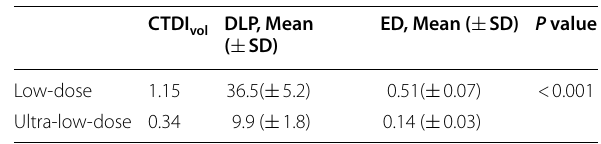
Table 5 Radiation dose results in low‑dose and ultra‑low‑dose